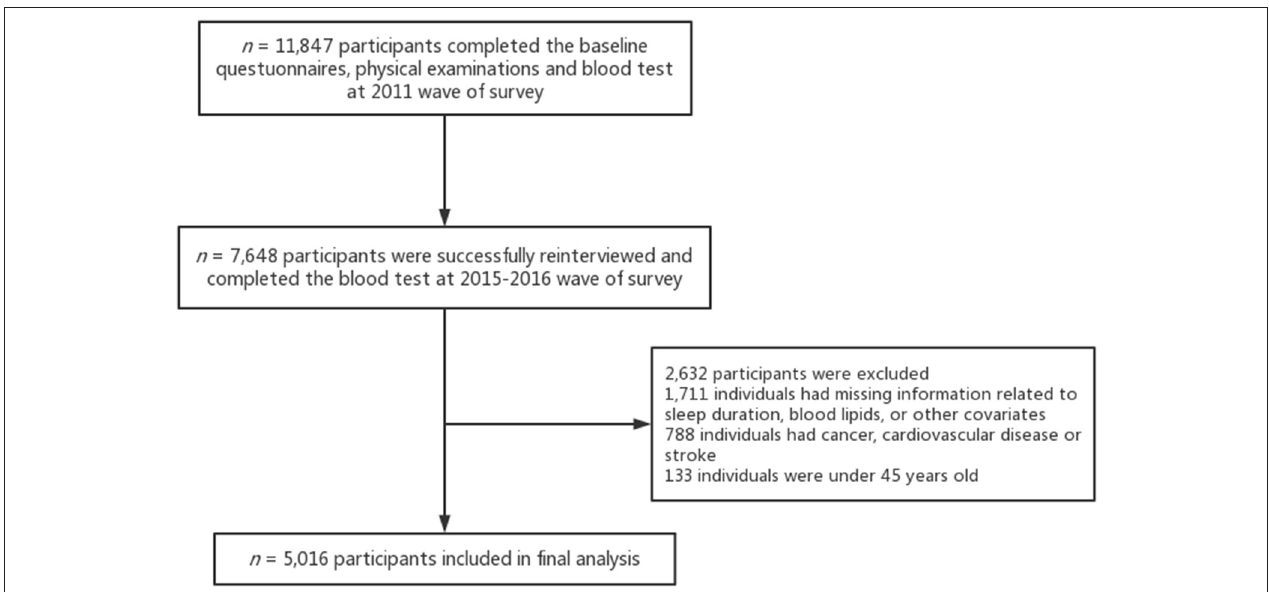
FIGURE 1 | The flowchart of the inclusion of participants.